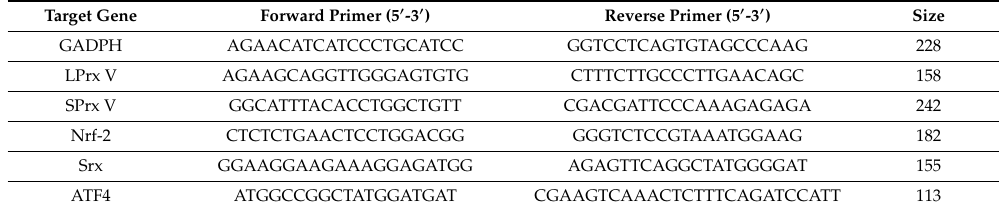
Table 1. Sequence of quantitative real-time polymerase chain reaction (qPCR)